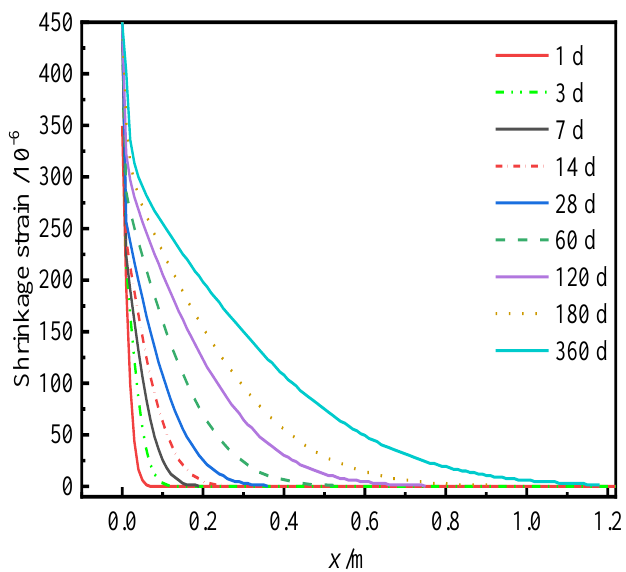
Figure 13. Dry shrinkage strain of CA mortar.